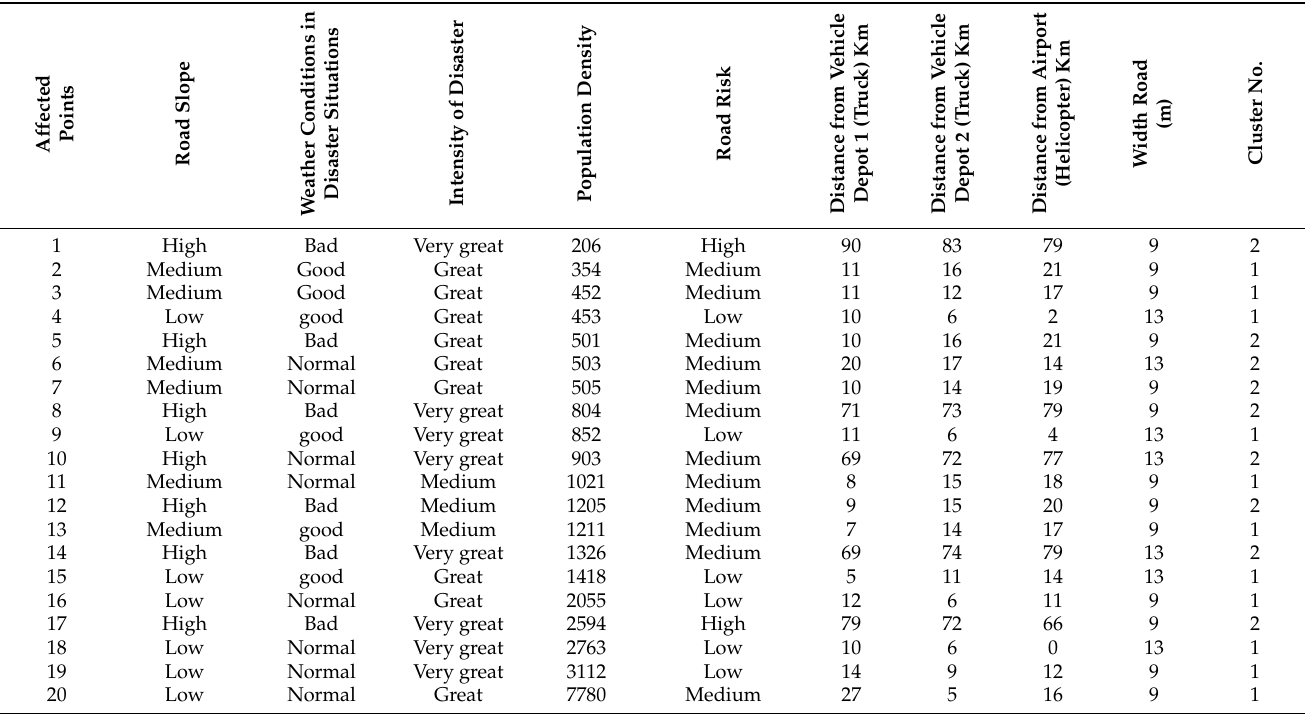
Table 1. A numerical illustration of affected point clustering using the ANFIS-FCM